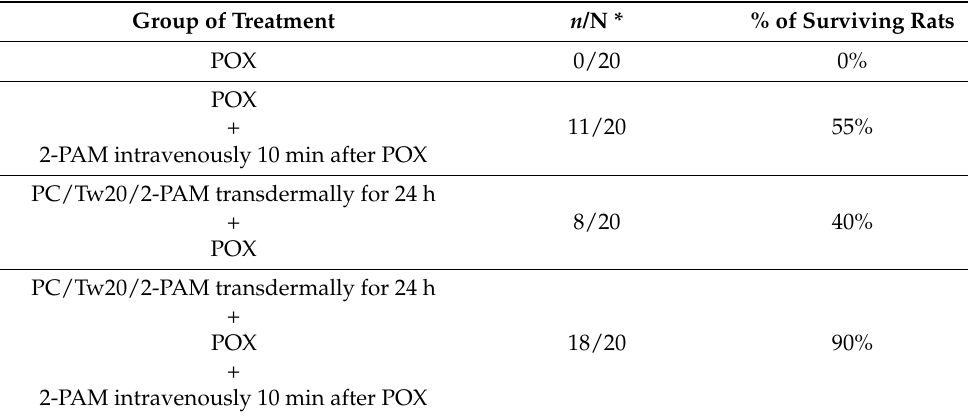
Table 5. Survival of rats poisoned with POX after different treatment strategies. Group of